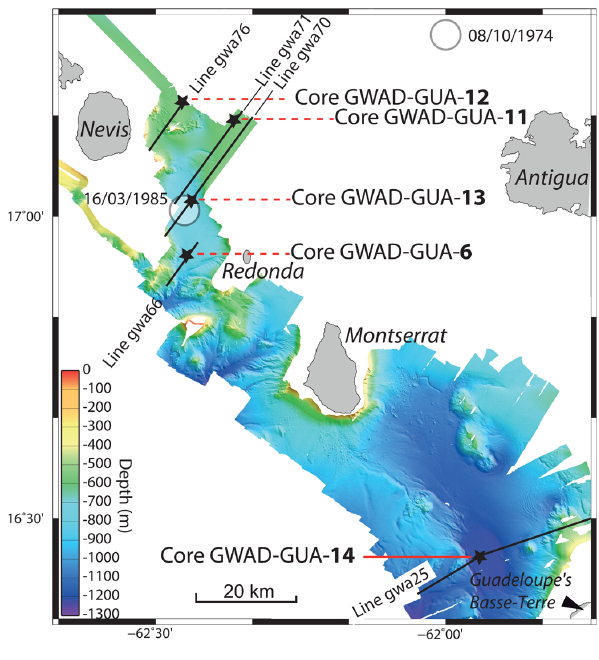
Fig. 2. Detailed bathymetry between Nevis and Guadeloupe is- lands. EM300 multibeam data from GWADASEIS cruise (100m of resolution). Location of seismic profiles shown in Fig. 3 and coring sites. (Area framed on Fig. 1)